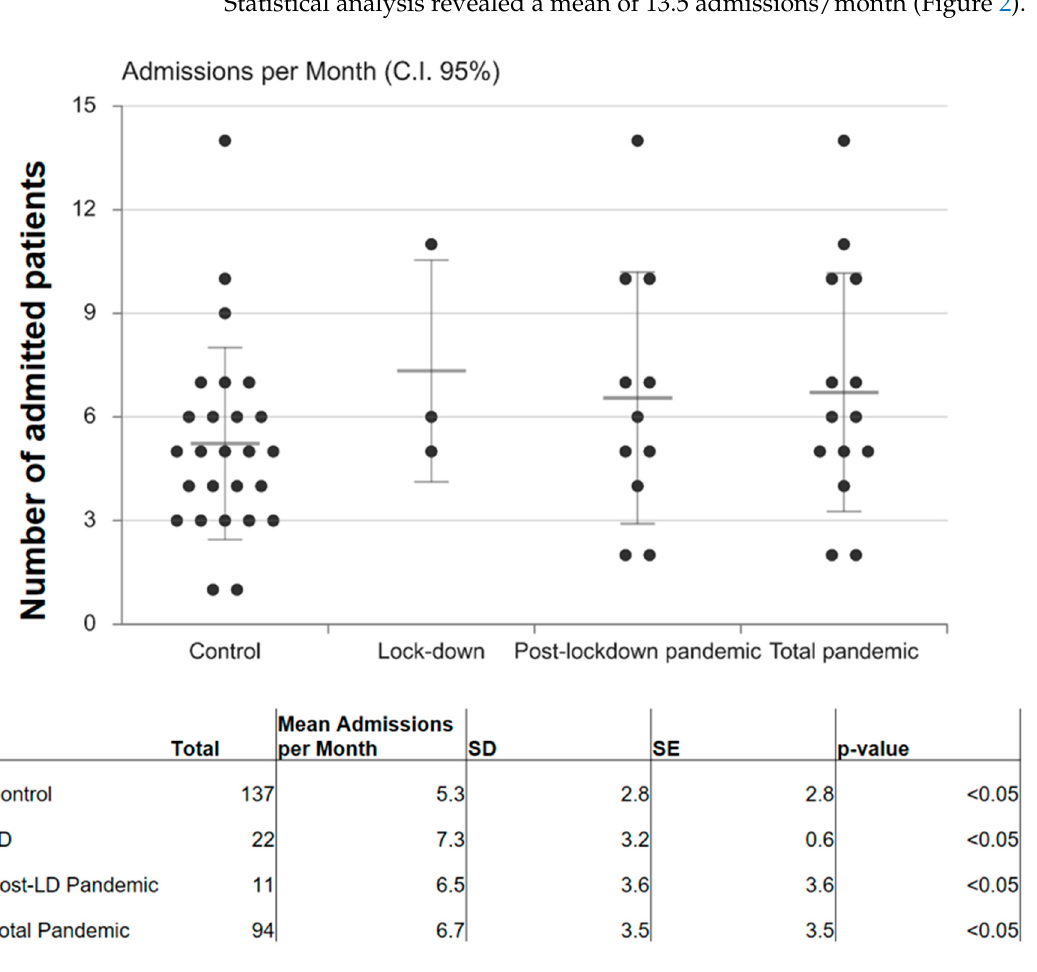
Figure 2. Dot plot of numbers of admissions per month; 95% confidence interval; p < 0.05. CI: confi- dence interval; SD: standard deviation; SE: standard error.